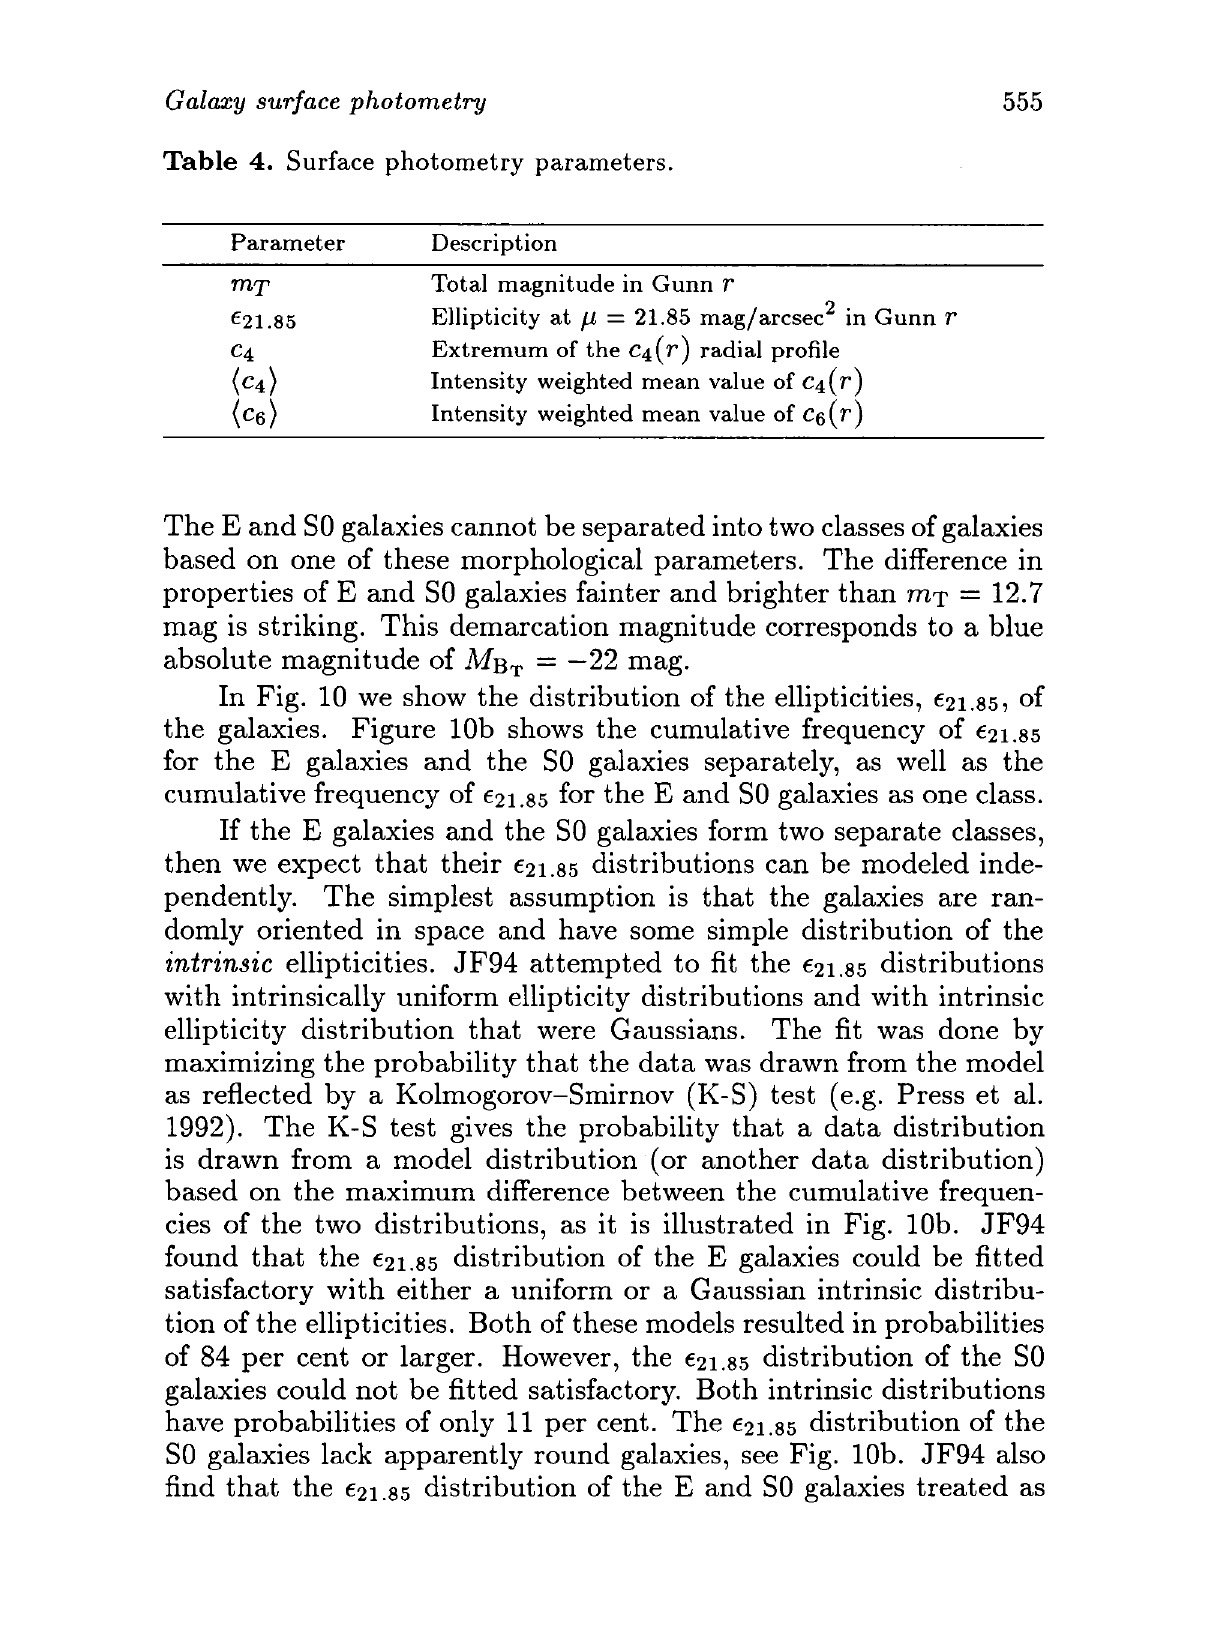
Table 4. Surface photometry